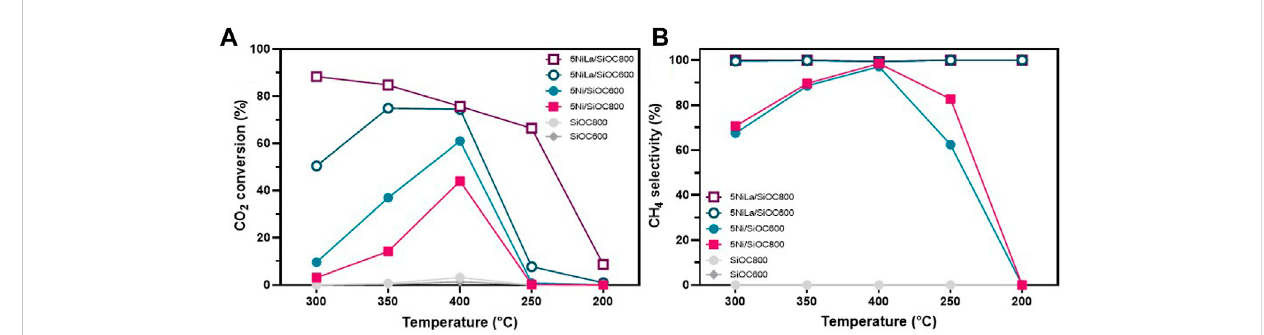
FIGURE 7 CO 2 conversion (A) and CH 4 selectivity (B) of samples on SiOC pyrolyzed at different temperatures, with and without La-modi fi cation. Please note that the x -axis is labelled according to the order of the temperature steps